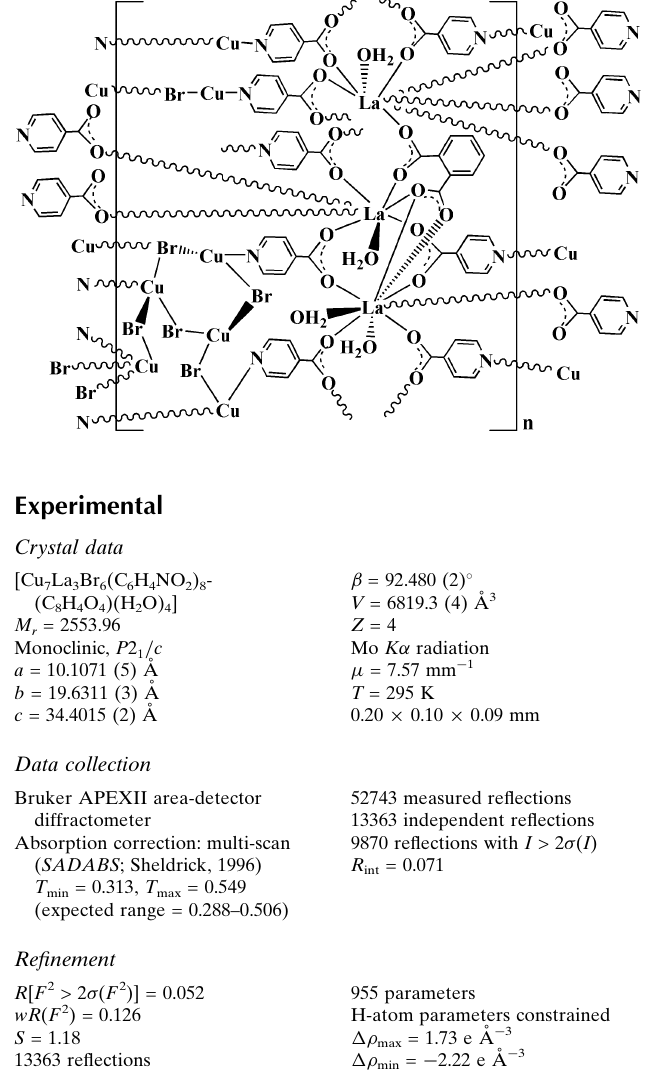
Data collection Bruker APEXII area-detector diffractometer Absorption correction: multi-scan ( SADABS ; Sheldrick, 1996)